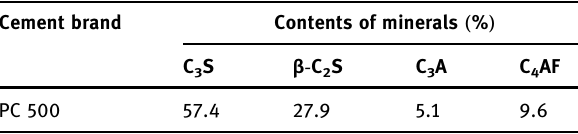
Table 2: Mineralogical composition of clinker Cement brand